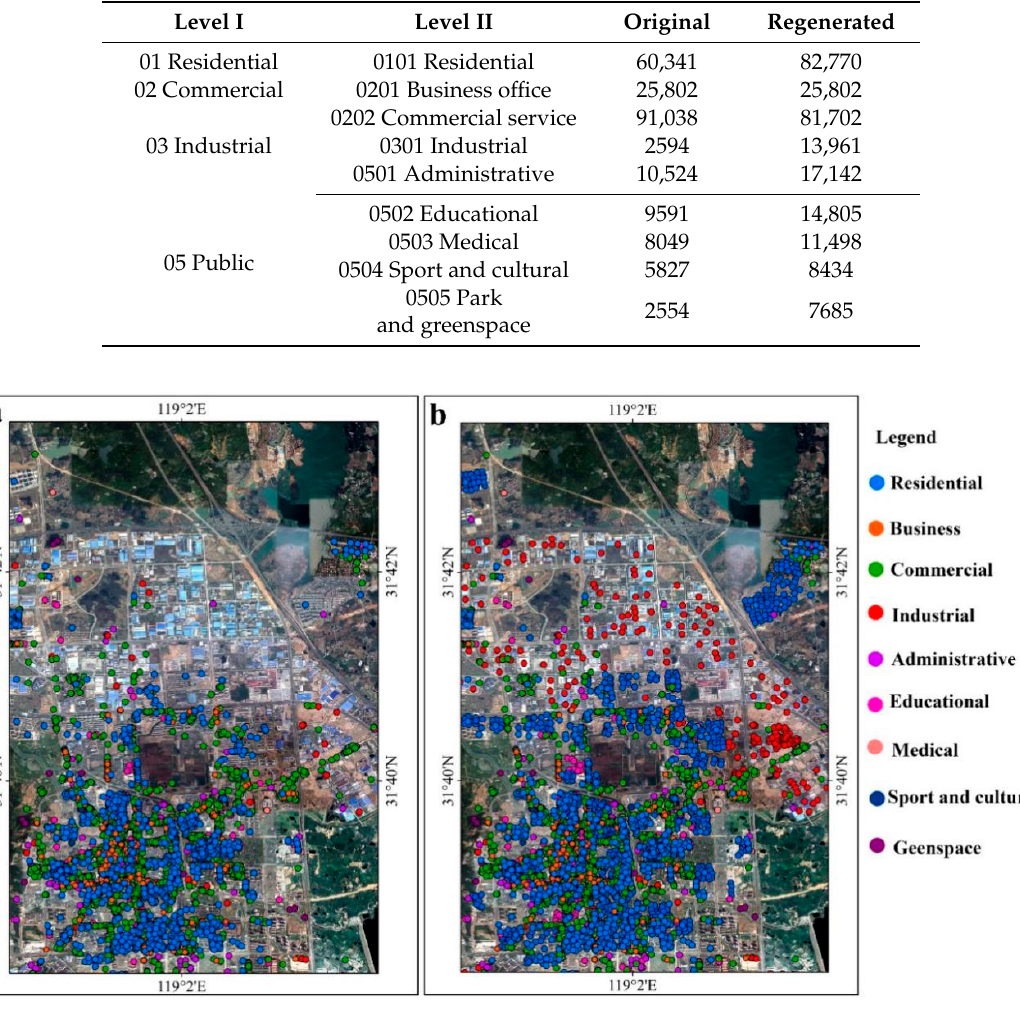
Figure 8. The classification overall accuracy with the varying number of features.